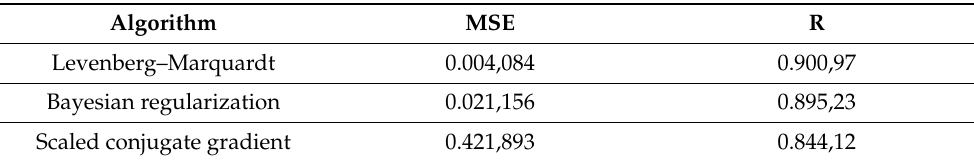
Table 2. Analysis of the efficiency of the algorithms.